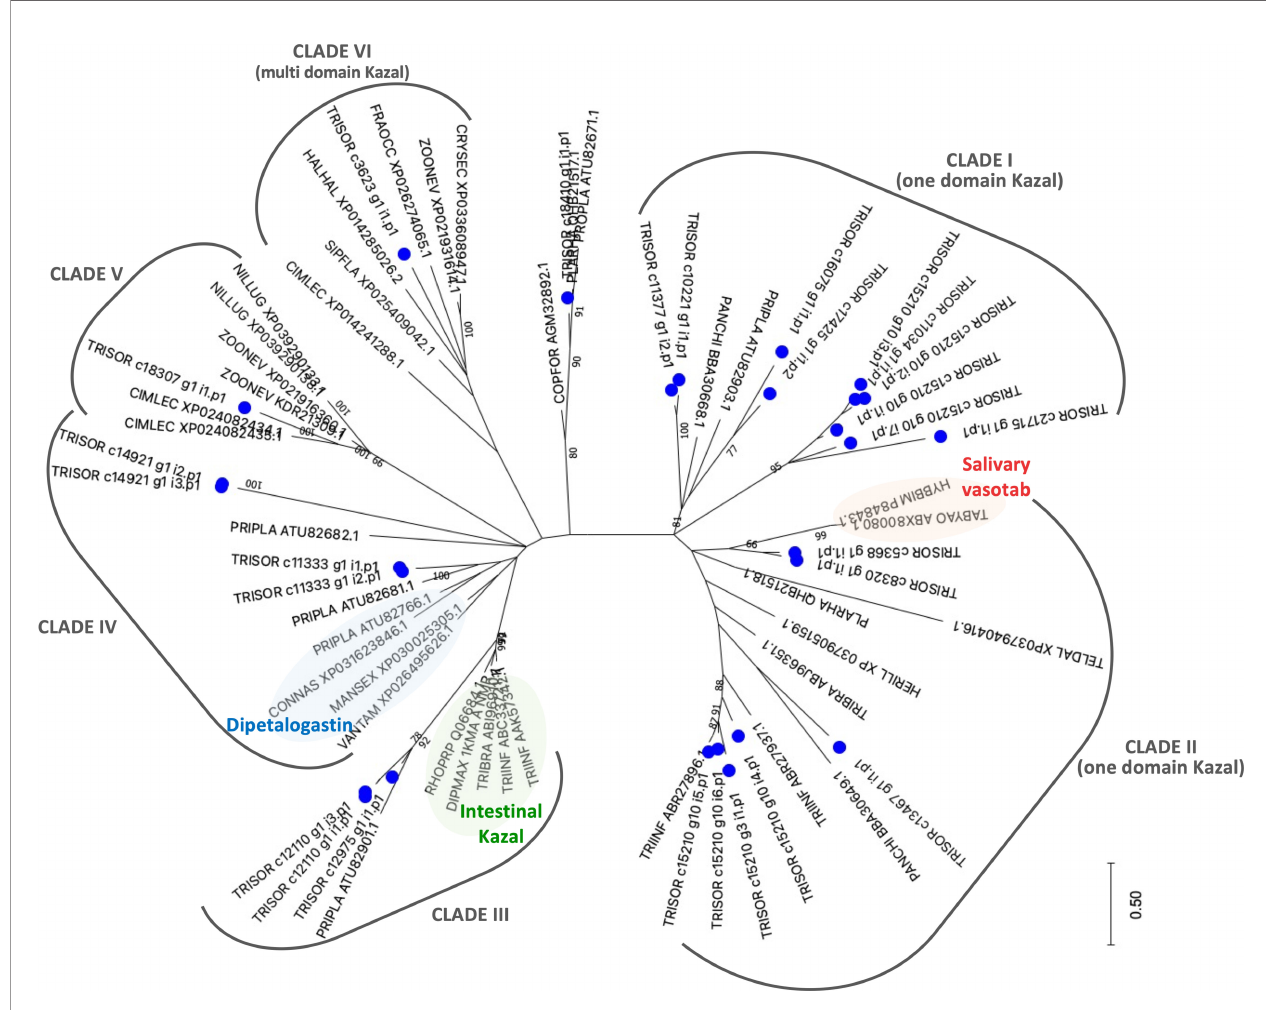
FIGURE 6 | The phylogenetic tree of Kazal-type members from Triatoma sordida sialotranscriptome. The distance tree among trialysin sequences is derived from the alignment of T. sordida CDS extracted from the sialotranscriptome analysis and other Kazal-type sequences (extracted from the non-redundant protein database of the NCBI applying PSI-BLAST algorithm) identi fi ed as described in Methods section. The blue circle identi fi es sequences from T. sordida . The number at the nodes indicates the bootstrap values. The scale on bottom measure evolutionary distance in substitutions per amino